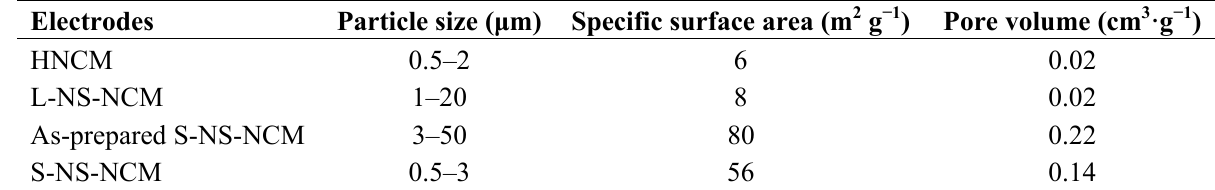
Table 1. Particle size, specific surface area, and pore volume of HNCM,